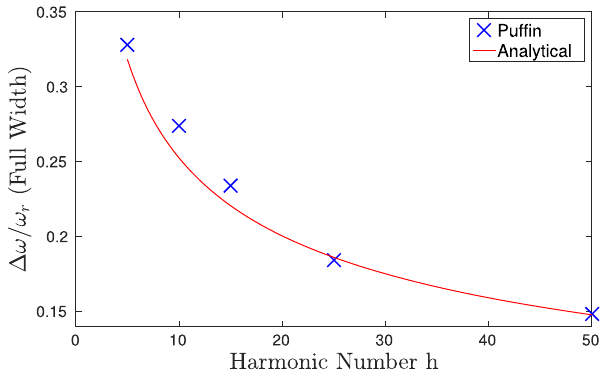
FIG. 7. Comparison between computational power spectrum full width (blue markers) and the analytical estimate based on Eq. (20).